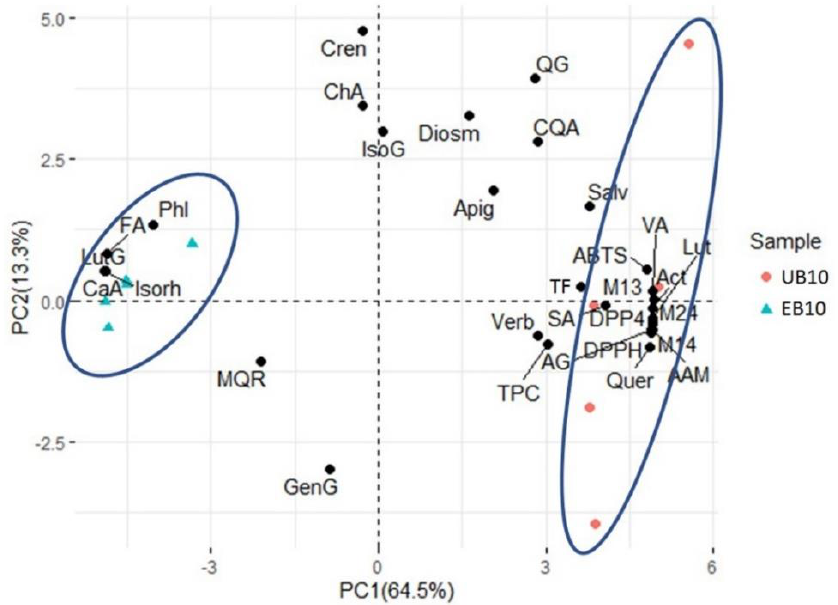
Figure 3. A biplot based on principal component analysis of metabolites and bioactivities. Samples are represented by colored-shapes and the variables by black points. CQA: 3- O -p-Coumaroylquinic